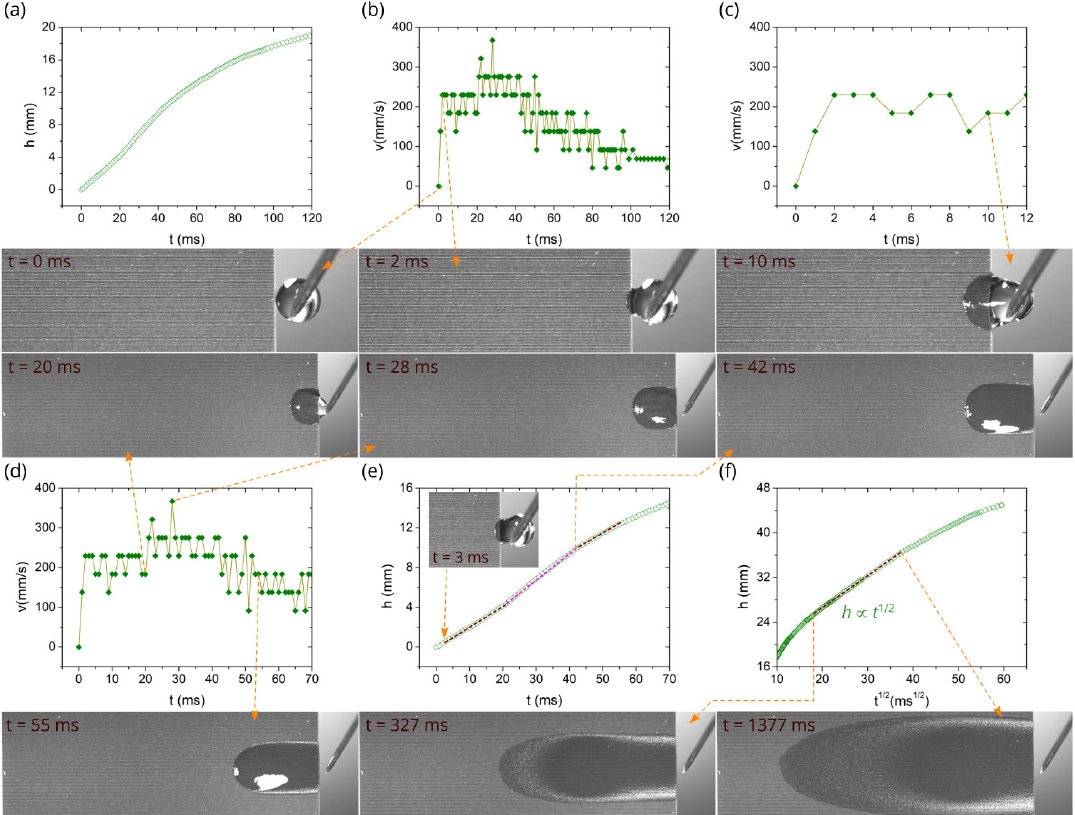
Figure 5. Detailed h ( t ) and v ( t ) plots along with snapshots of water spreading at 60 ◦ C. ( a ) Plot of the spreading distance as a function of time between 0 and 120 ms. ( b ) Plot of the velocity as a function of time between 0 and 120 ms. ( c ) Plot of the velocity as a function of time between 0 and 12 ms. ( d ) Plot of the velocity as a function of time between 0 and 70 ms. ( e ) Detailed plot of the spreading distance as a function of time between 0 and 70 ms. ( f ) Plot of the spreading distance as a function of t 1 / 2